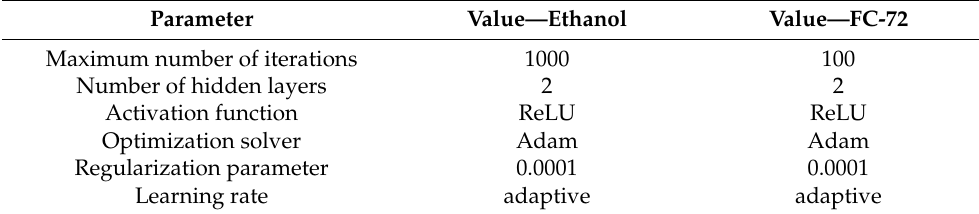
Table 8. Optimal hyperparameters for multilayer perceptron classifier.